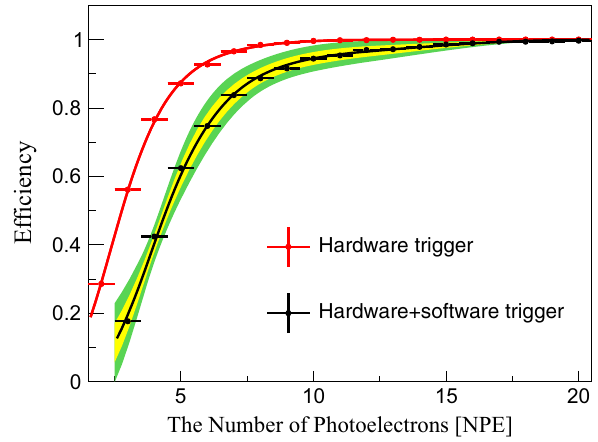
Fig. 21 Hardware and software trigger efficiencies from the simulated events are